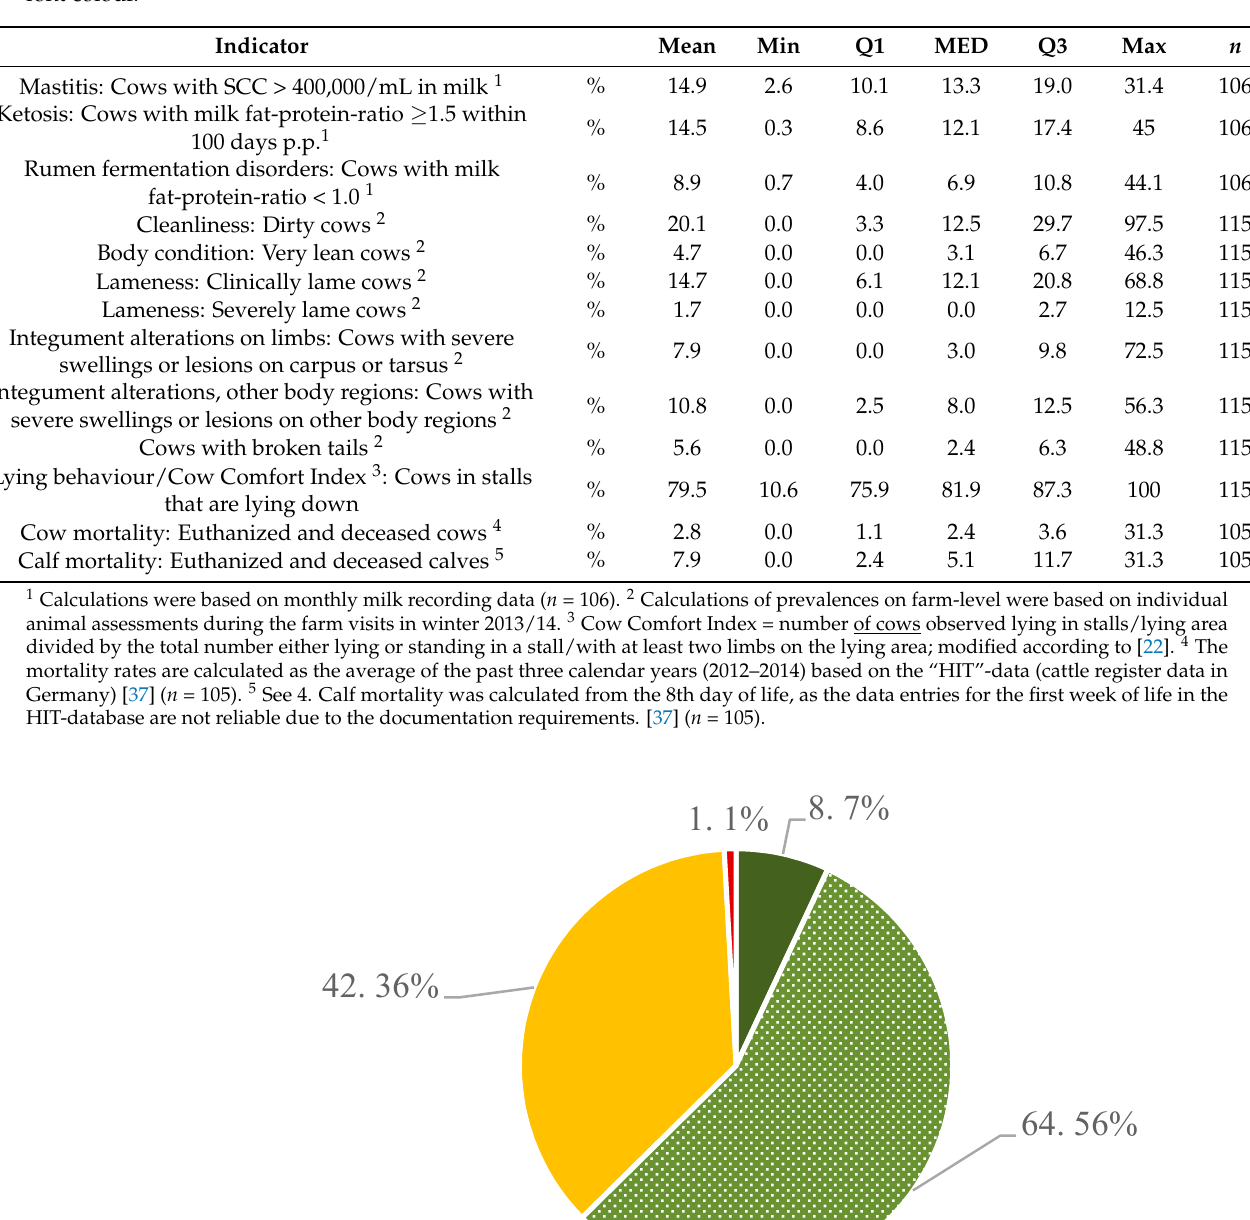
Table 3. Indicator values of the 115 farms surveyed in 2014 (mean, median = MED, minimum = min, maximum = max and quartiles = Q). Indicators excluded from the final list have a red font colour. Indicators added to the final list have a green font colour.